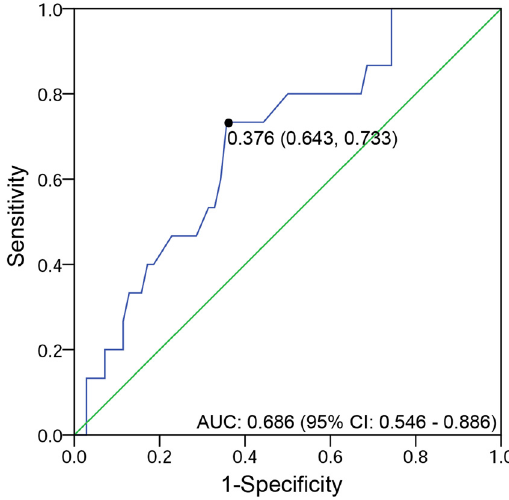
Figure 1: ROC curve analysis of the optimal C proportion for pre - dicting renal survival.